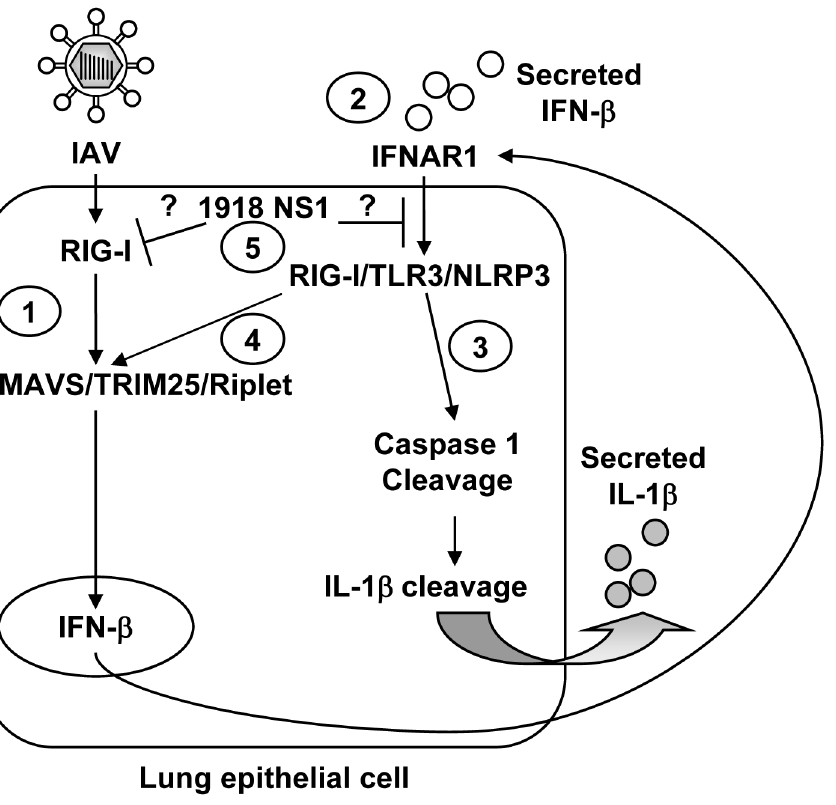
Figure 7. Proposed model of RIG-I as a pivotal regulator of the inflammasome response against IAV in lung epithelial cells. 1) Upon IAV infection, RIG-I senses viral genomic RNA and triggers a type I interferon response through a MAVS/TRIM25/Riplet-dependent pathway. 2) Binding of type I interferon to IFNAR1 initiates a positive feedback loop that stimulates RIG-I/TLR3/NLRP3 expression. 3) This upregulation is necessary for RIG- I- and NLRP3-inflammasome assembly, cleavage of caspase 1 and, ultimately, mature IL-1 b secretion. 4) RIG-I upregulation stimulates type I IFN and constitutes an additional positive feedback loop. 5) 1918 NS1 could form more prominent complexes with RIG-I than USSR NS1, and/or target other cellular component(s) involved in type I IFN signaling, to result in a stronger inhibition of RIG-I-dependent type I interferon response by NS1 from the highly virulent pandemic 1918 influenza strain. 1918 NS1 protein-mediated inhibition of the type I IFN response consequently decreases IL-1 b